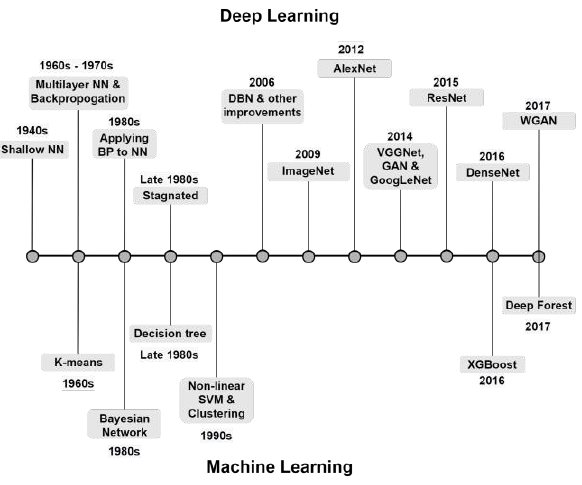
Figure 1. Timeline of the development of DL and commonly used ML algorithms (modified after Cao et al., 2018). NN: neural network; BP: backpropagation; DBN: deep belief network; SVM: support vector machines; AE: auto-encoder; VAE: variational AE; GAN: generative adversarial network; XGBoost: Extreme Gradient Boost; WGAN: Wasserstein GAN